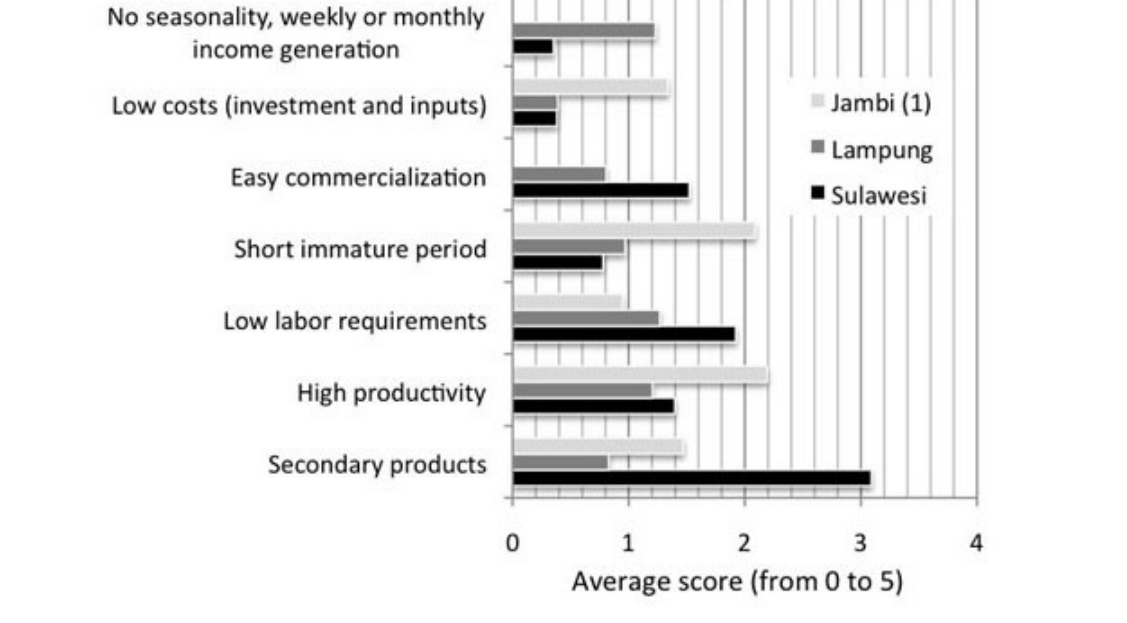
Fig. 3 . Farmers’ reasons for choosing a perennial crop (responses to perception survey) (adapted from Therville 2008). These are the reasons farmers most often gave for their choice of crop among oil palm, rubber, cocoa, and coffee. These arguments are linked more to the species than to how it is planted in agroforest or in